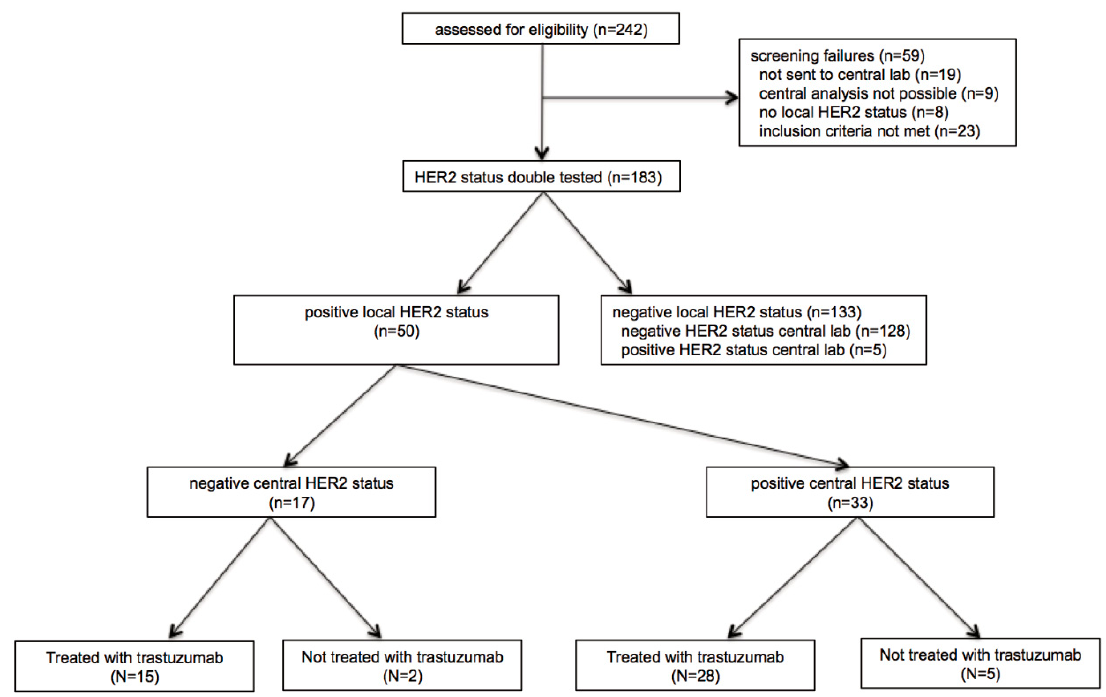
Figure 1. Consort diagram GASTRIC-5 registry.